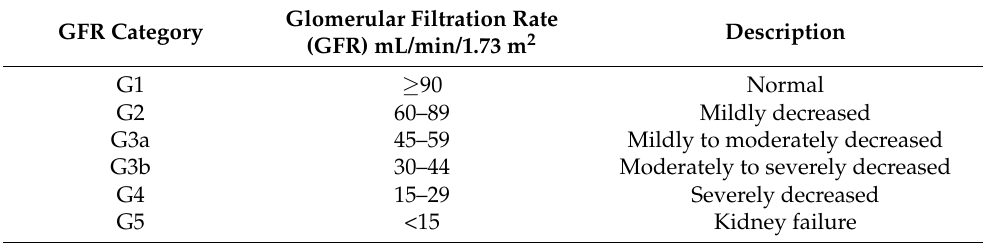
Table 1. The K/DOQI-CKD staging depends on the GFR (glomerular filtration rate). The stadiums between Grades 1–5 (G1–5) depend on the eGFR. GFR